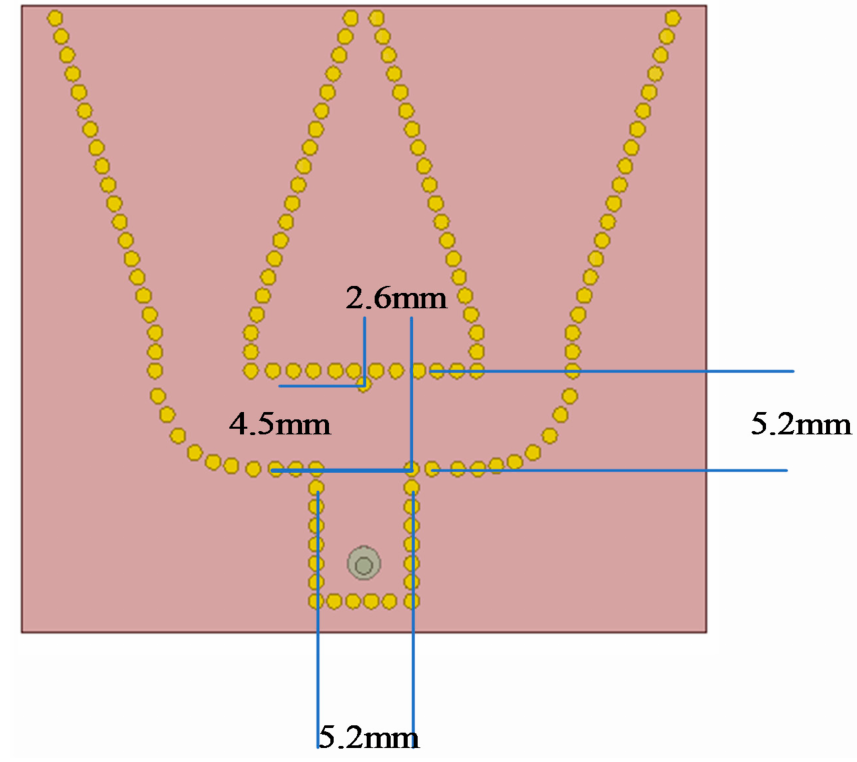
Figure 6. Location of the additional